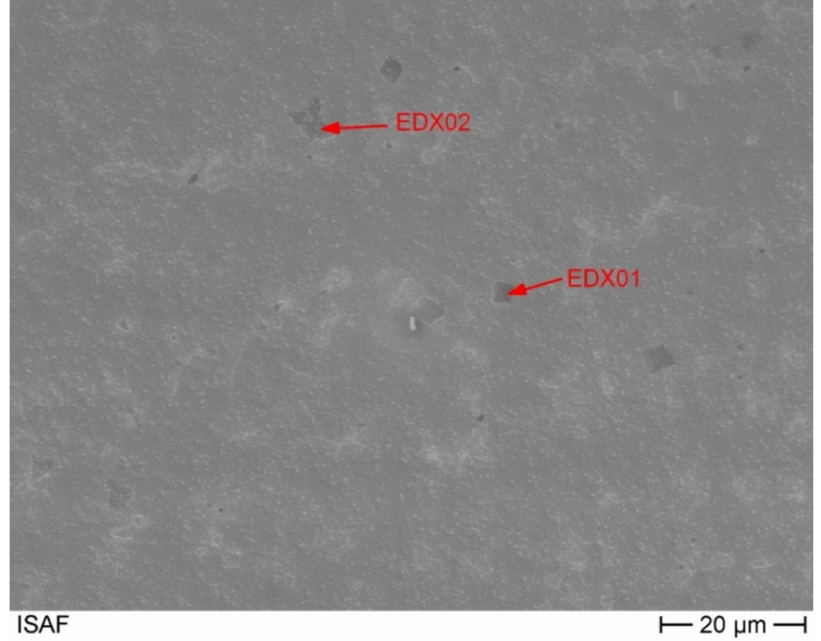
Figure 4. SEM image of the alloy with marks for EDX measurements of precipitates. Table 4. Chemical composition of the precipitates (EDX). Position Element in